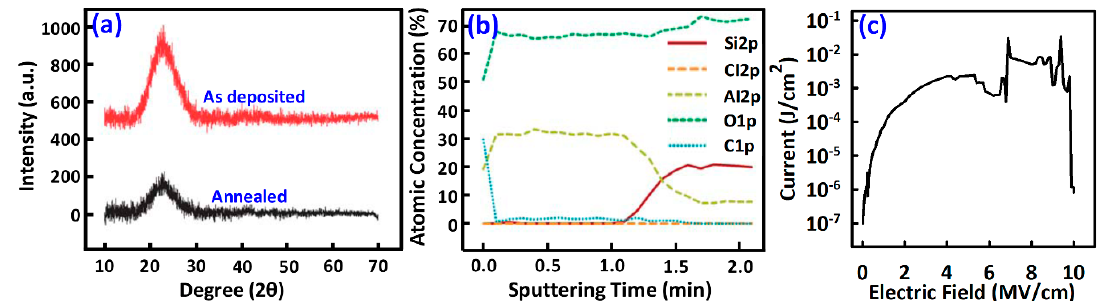
Figure 5. ( a ) XRD patterns of the solution processed AlO x layer as deposited ( top ), and after 350 °C annealing ( bottom ). ( b ) XPS spectra of the solution processed AlO x layer after annealing at 350 °C. Current–voltage (J–V) characteristics of the AlO x layer showing a breakdown voltage of approximately 4 MV/cm.